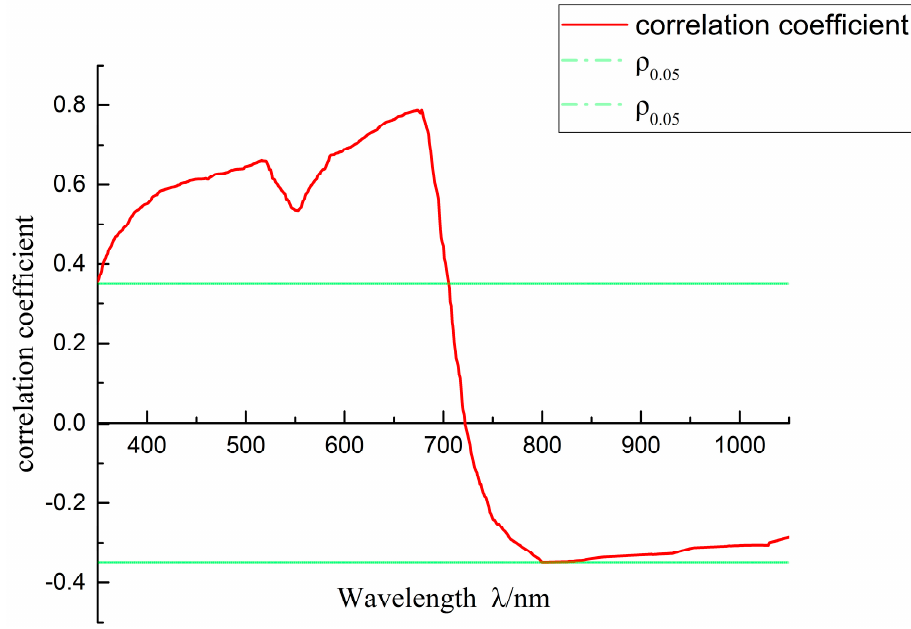
Figure 6. The correlation between amount of dust and spectral reflectance ratio (dust and